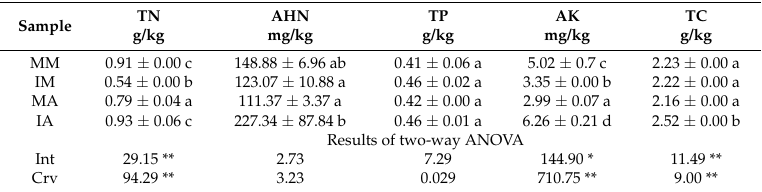
Table 1. Physicochemical parameters of different